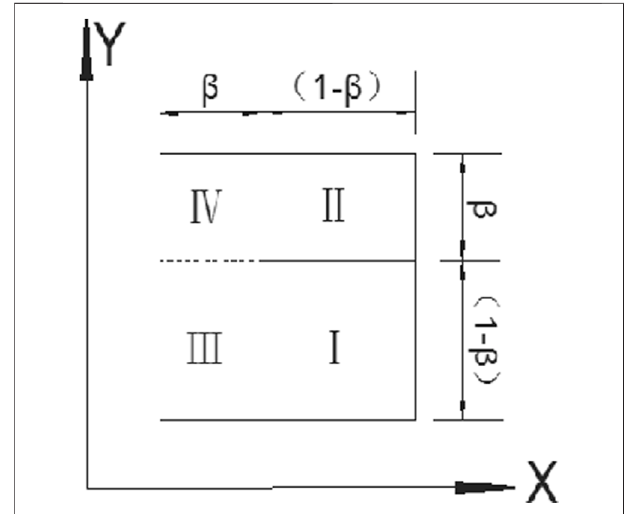
FIGURE 2 | Representative element (Yang and Wu,